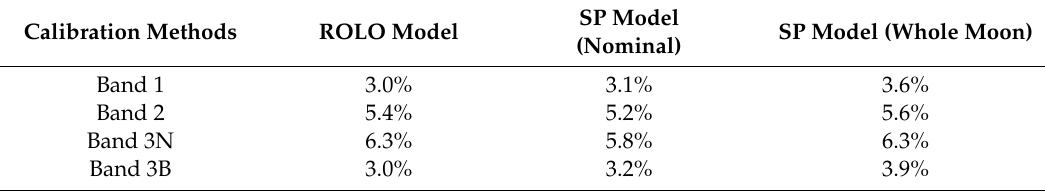
Table 3. Percentages of the sensor sensitivity degradation of the ASTER/VNIR bands from 2003 to 2017 measured from the lunar calibration based on Spectral Profiler (SP) and RObotic Lunar Observatory (ROLO) models. SP model (nominal) indicates the lunar calibration results using a limited region of the lunar disk according to the recommendation of [19], and SP model (whole Moon) indicates using the whole lunar